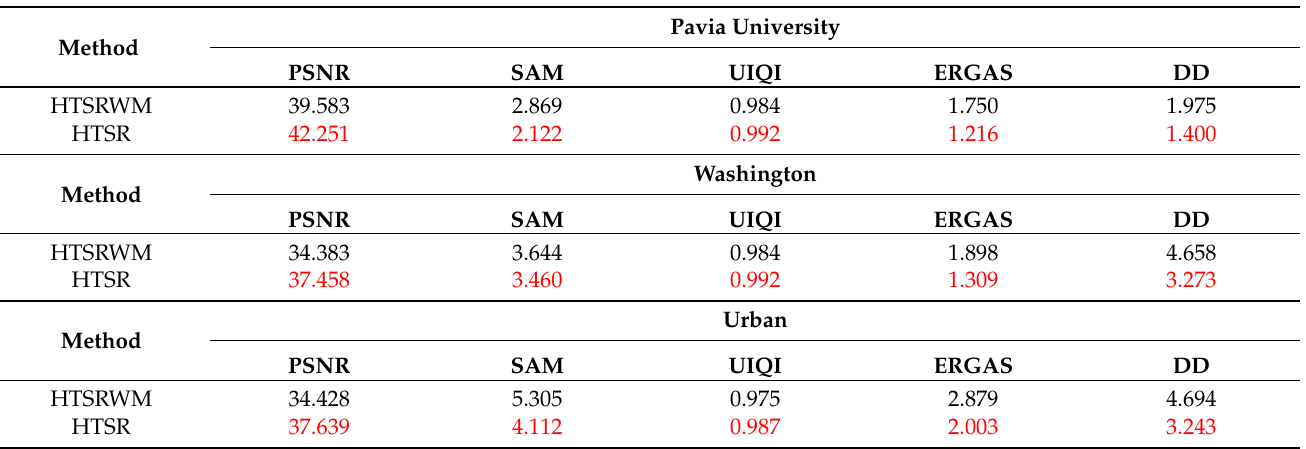
Table 5. Quantitative metrics of HTSRWM method and HTSR method on the Pavia University, Washington DC Wall and Urban data